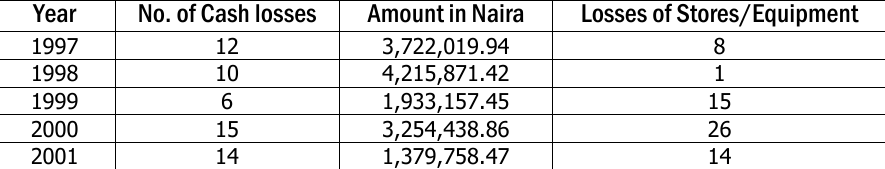
TABLE 5: Comparative losses in the Federal Ministries